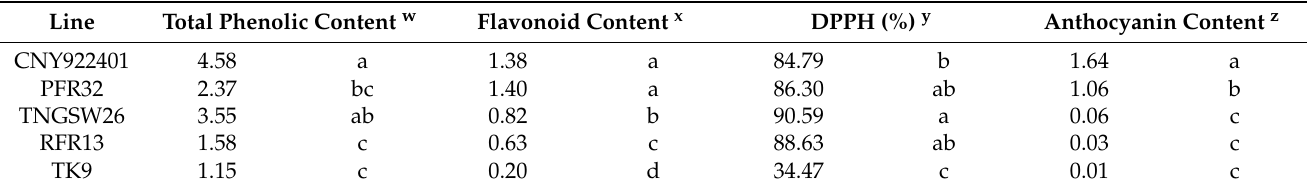
Table 4. Total phenolic content, flavonoid content, DPPH scavenging activity, and anthocyanin content of CNY922401, PFR32, TNGSW 26, RFR13 and Taiken 9